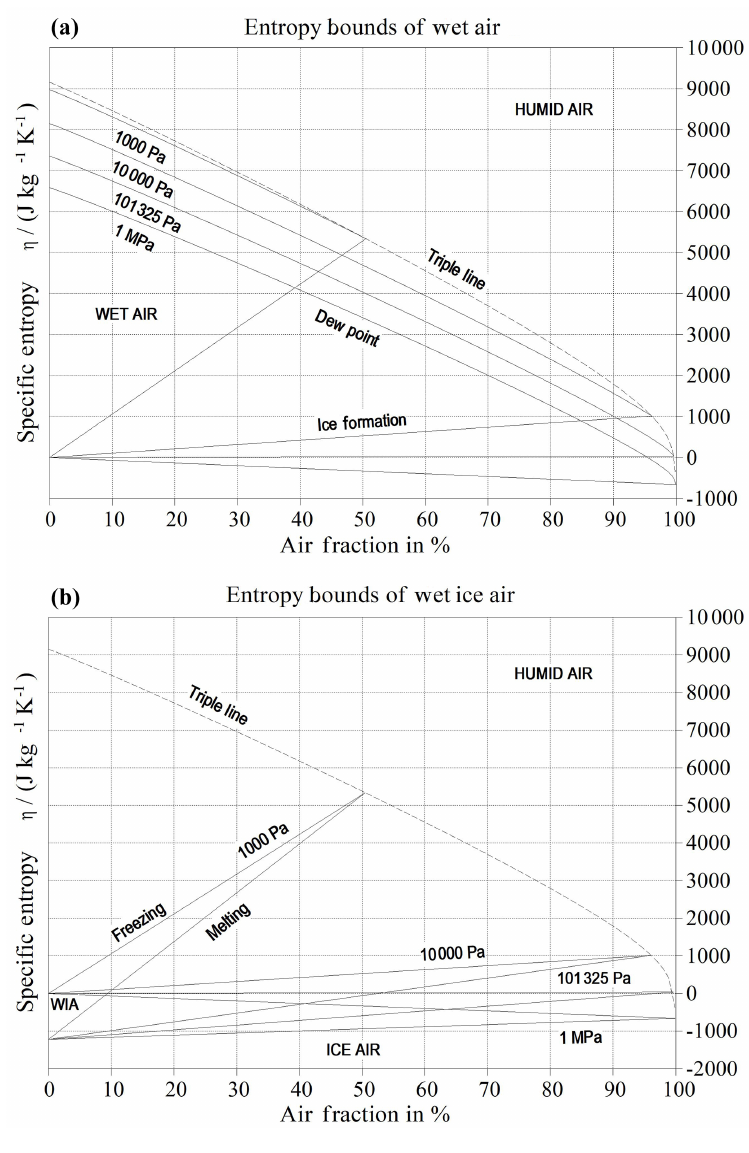
Figure 6. Phase diagrams of composite air–water–ice systems (“clouds”), depending on the entropy and dry-air mass fraction of a given parcel, computed from TEOS-10 (Feistel et al., 2010a). Natural clouds with air fractions of 98–99% at pressures between 20000 and 101325Pa are located in the lower right corner of the diagrams. Metastable states, such as subcooled liquid droplets (WMO, 2008), are not considered here. (a) In the triangle-shaped, two-phase regions “wet air”, humid air is in equilibrium with liquid water. The tips of these wet- air wedges are triple points located along the “triple line” depending on the pressure (or altitude) as indicated. Above the wedge, between the “dew point” curve and “triple line”, humid air is the only stable phase. Between “dew point” and “ice formation”, liquid water is in equilibrium with humid air. (b) In the triangle-shaped, three-phase regions “WIA” (wet ice air), humid air is in equilibrium with both liquid water and ice at the same time. The tips of these WIA wedges are triple points located along the “triple line” depending on the pressure (or altitude) as indicated. Above the wedge, the cloud contains only liquid water (wet air), if at all, while below the wedge, ice is the only condensed stable phase (ice air) in equilibrium with humid air. When adiabatically ascending, the entropy and dry-air fraction of an air parcel remain unchanged, even when passing the transition to cloud formation (the isentropic condensation level), and so does the parcel’s representative point in the diagrams. With decreasing pressure, the “wet-air” and “wet-ice-air” regions will pan to the left, and states located initially between the “dew point” and “triple line” get into the wet- air region first, then become wet ice air, and finally ice air. Points located above the “triple line” condensate to ice directly without passing any intermediate liquid phase. Using such diagrams, the parcel’s phase changes during convection may be predicted from its conservative properties at the